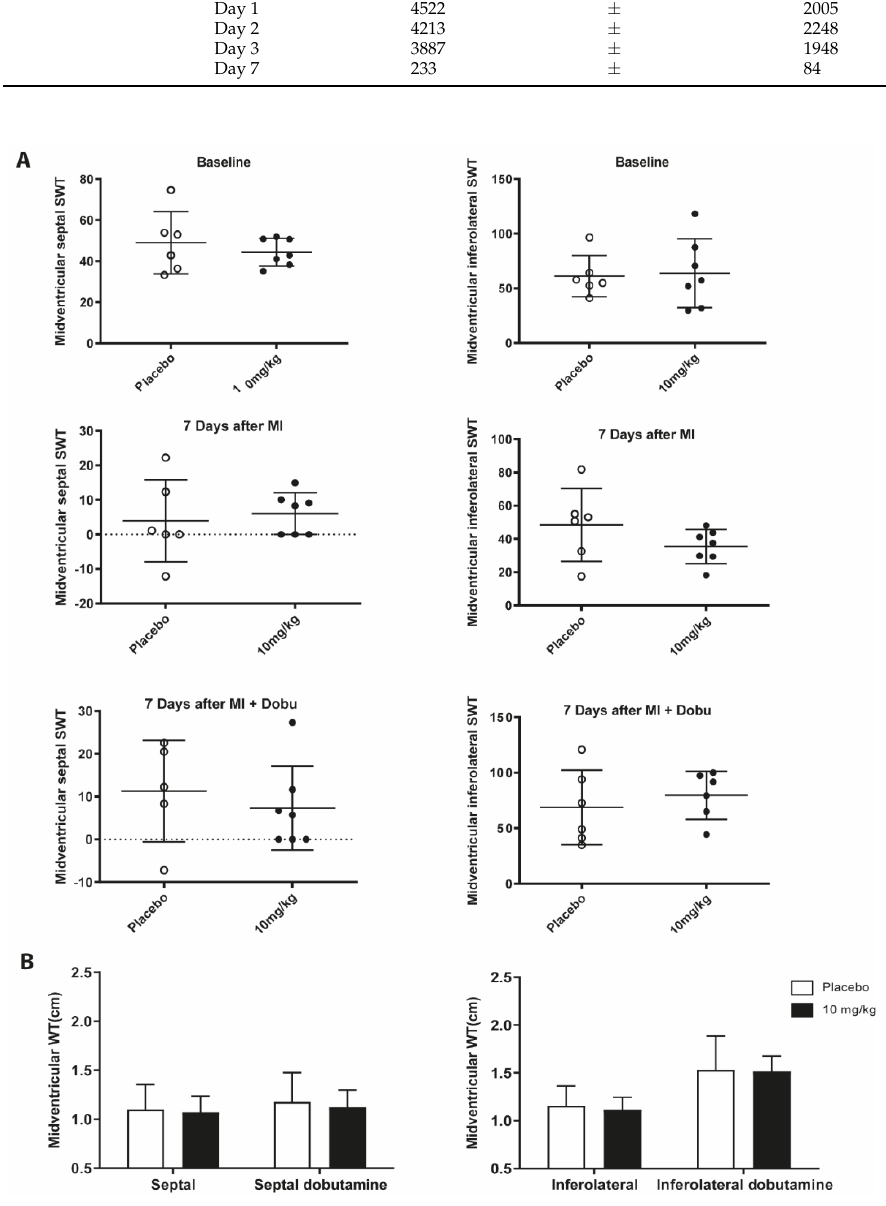
Figure A1. Regional cardiac function and dobutamine echocardiography in animals treated with placebo or 10 mg/kg IZD334. ( A ) Septal and inferolateral systolic wall thickening; SWT (%) at baseline and 7 days after MI with or without dobutamine. ( B ) Systolic wall thickness; WT (cm) ( n = 5 – 7).